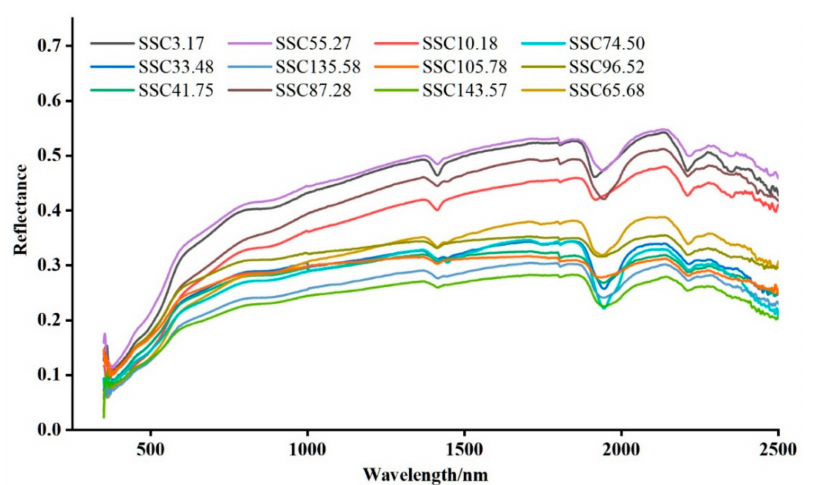
Figure 2. Spectral curves of soil samples corresponding to different soil salinity levels measured in the laboratory using an analytical spectral device